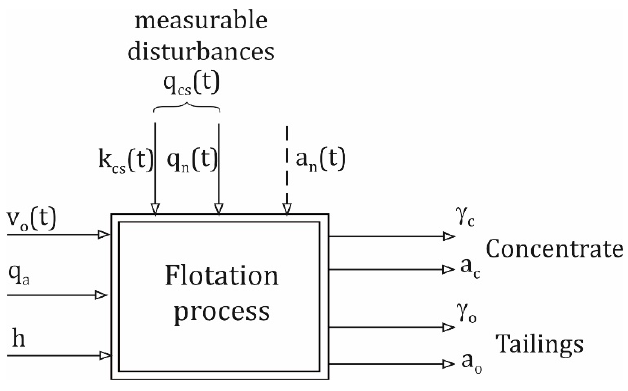
Figure 1. Coal flotation process as a control object.